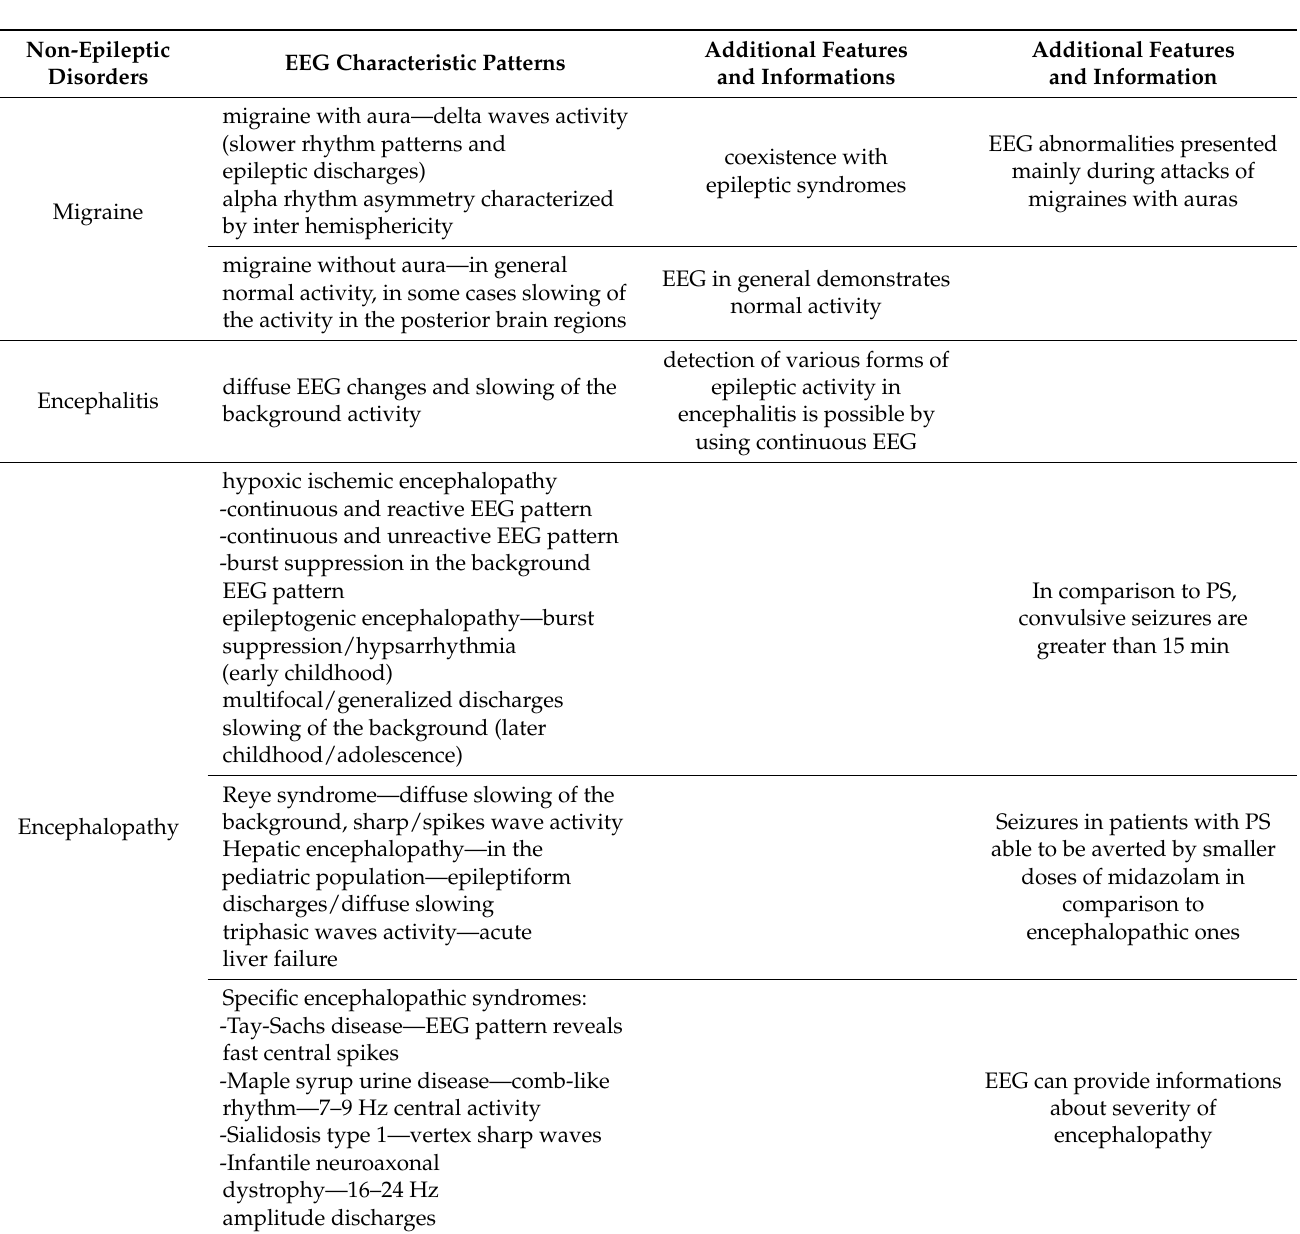
Table 3. This table compares characteristic EEG related to selected non-epileptic disorders. Character- istic for